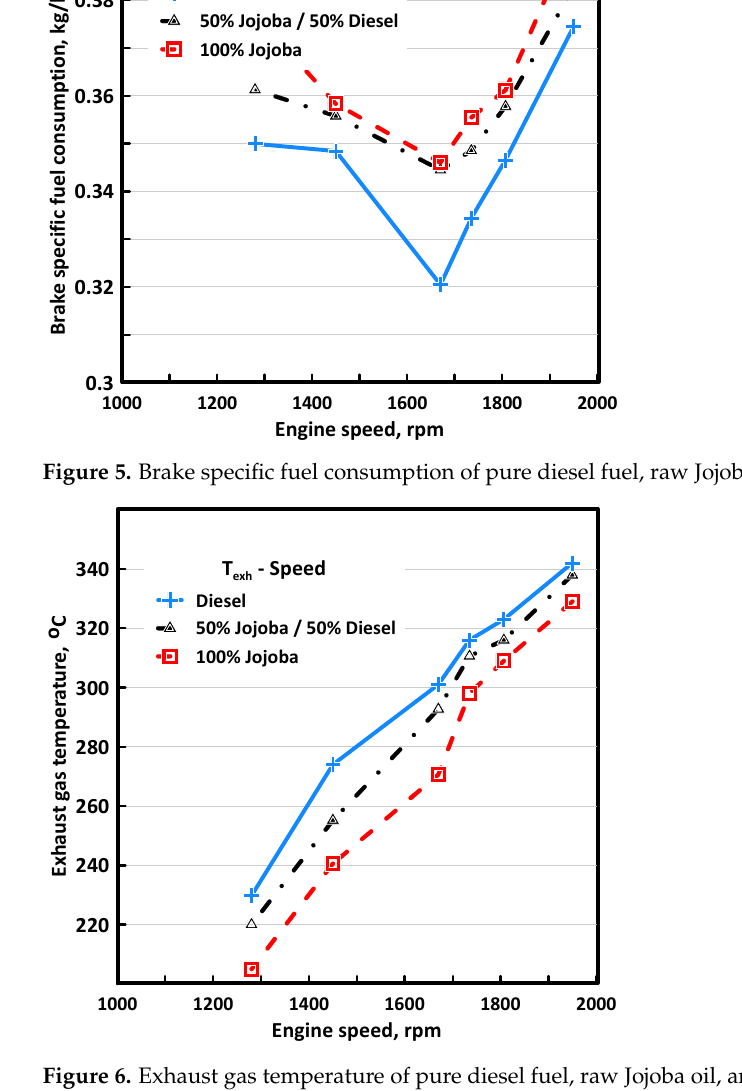
Figure 6. Exhaust gas temperature of pure diesel fuel, raw Jojoba oil, and 50/50 blend.